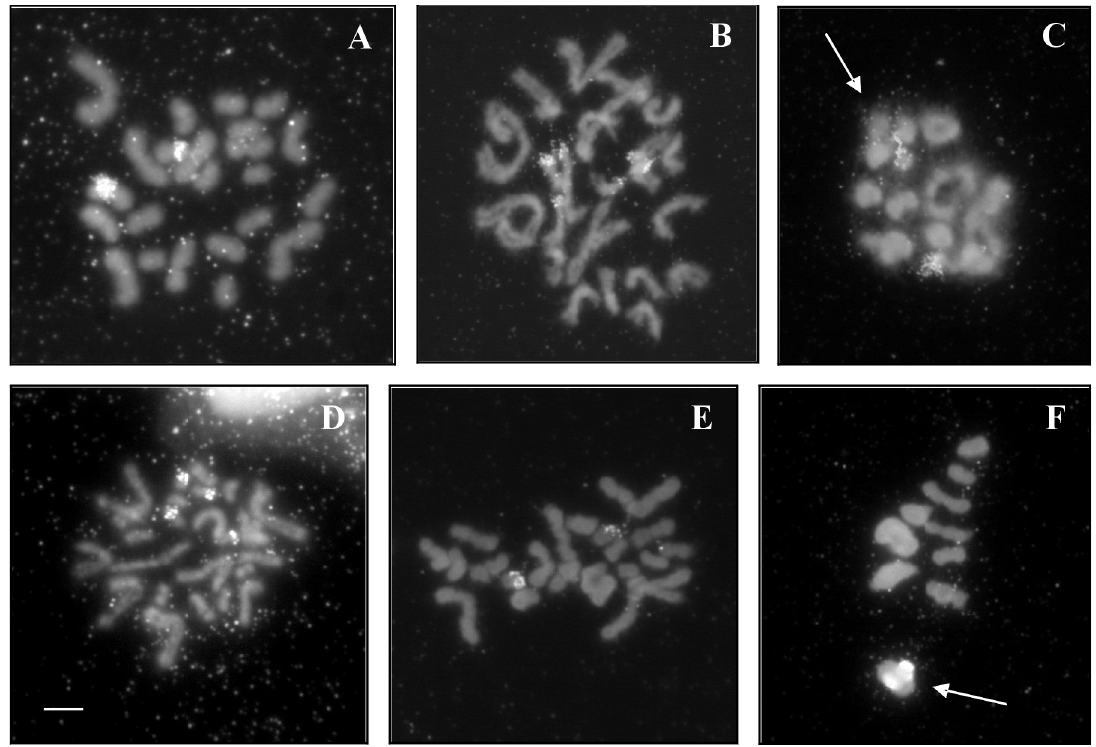
Figure 4 - Fluorescent in situ hybridization with a 18S rDNA probe of the chromosomes of the species of tiger beetles studied. (A) Cicindela argentata , female mitotic metaphase with two chromosomes labelled; (B) Cicindela aurulenta , female mitotic metaphase showing hybridization in six chromo- somes;(C) C.aurulenta ,malemetaphaseIwithtwosignalsinthesexcomplexplustwosignalsinoneautosomalbivalent;(D) Cicindelasuturalis ,female mitotic metaphase showing four labeled chromosomes; (E) C. suturalis , male mitotic metaphase with fluorescence in two chromosomes; (F) C. suturalis , male metaphase I with two fluorescence signals in the sex complex. Arrows indicate the sex complex. Bar = 4 µ